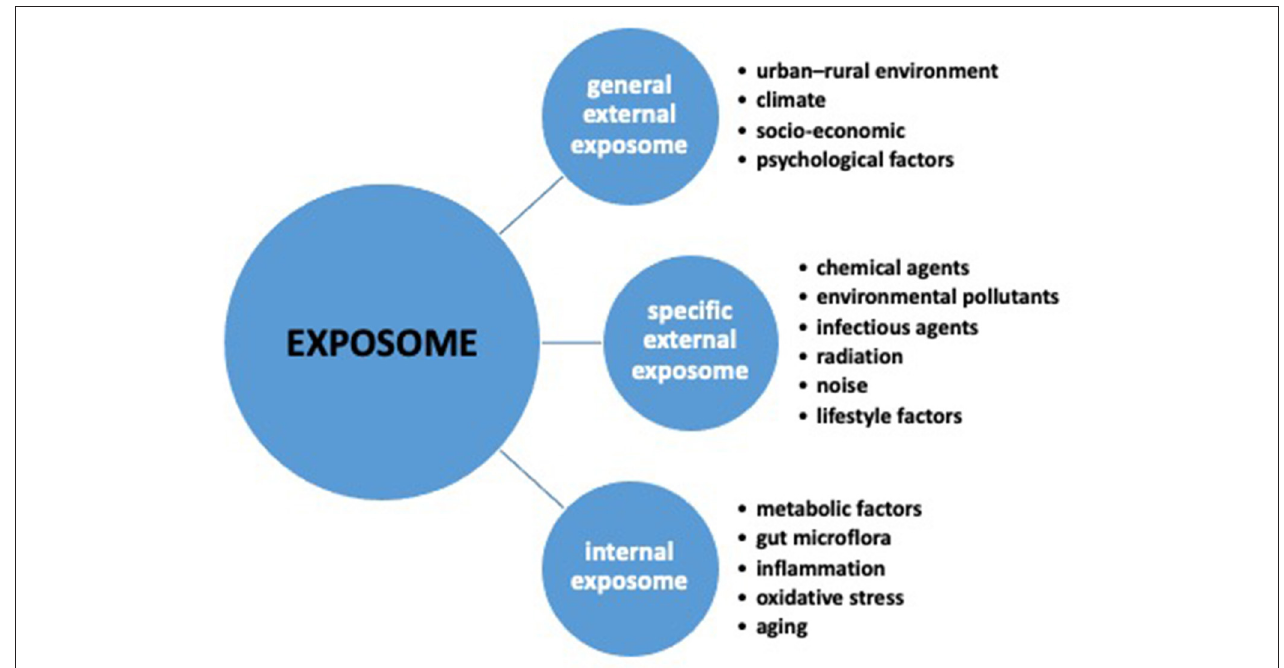
FIGURE 1 | The three exposome domains: general external, specific external and internal.